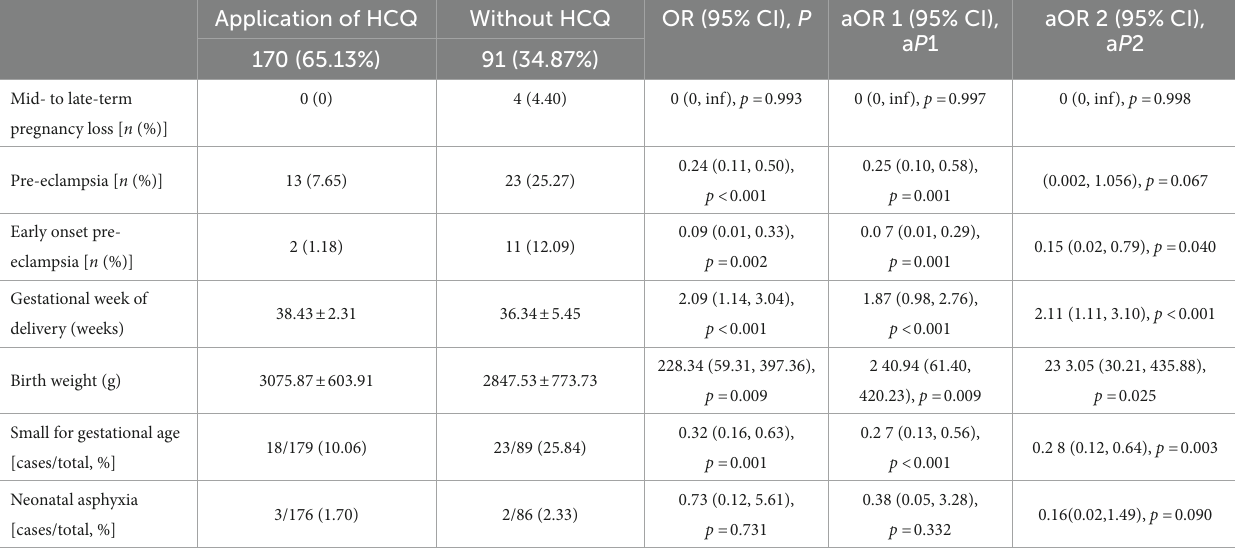
TABLE 2 Analysis of hydroxychloroquine and pregnancy outcomes in the population with positive antinuclear antibody